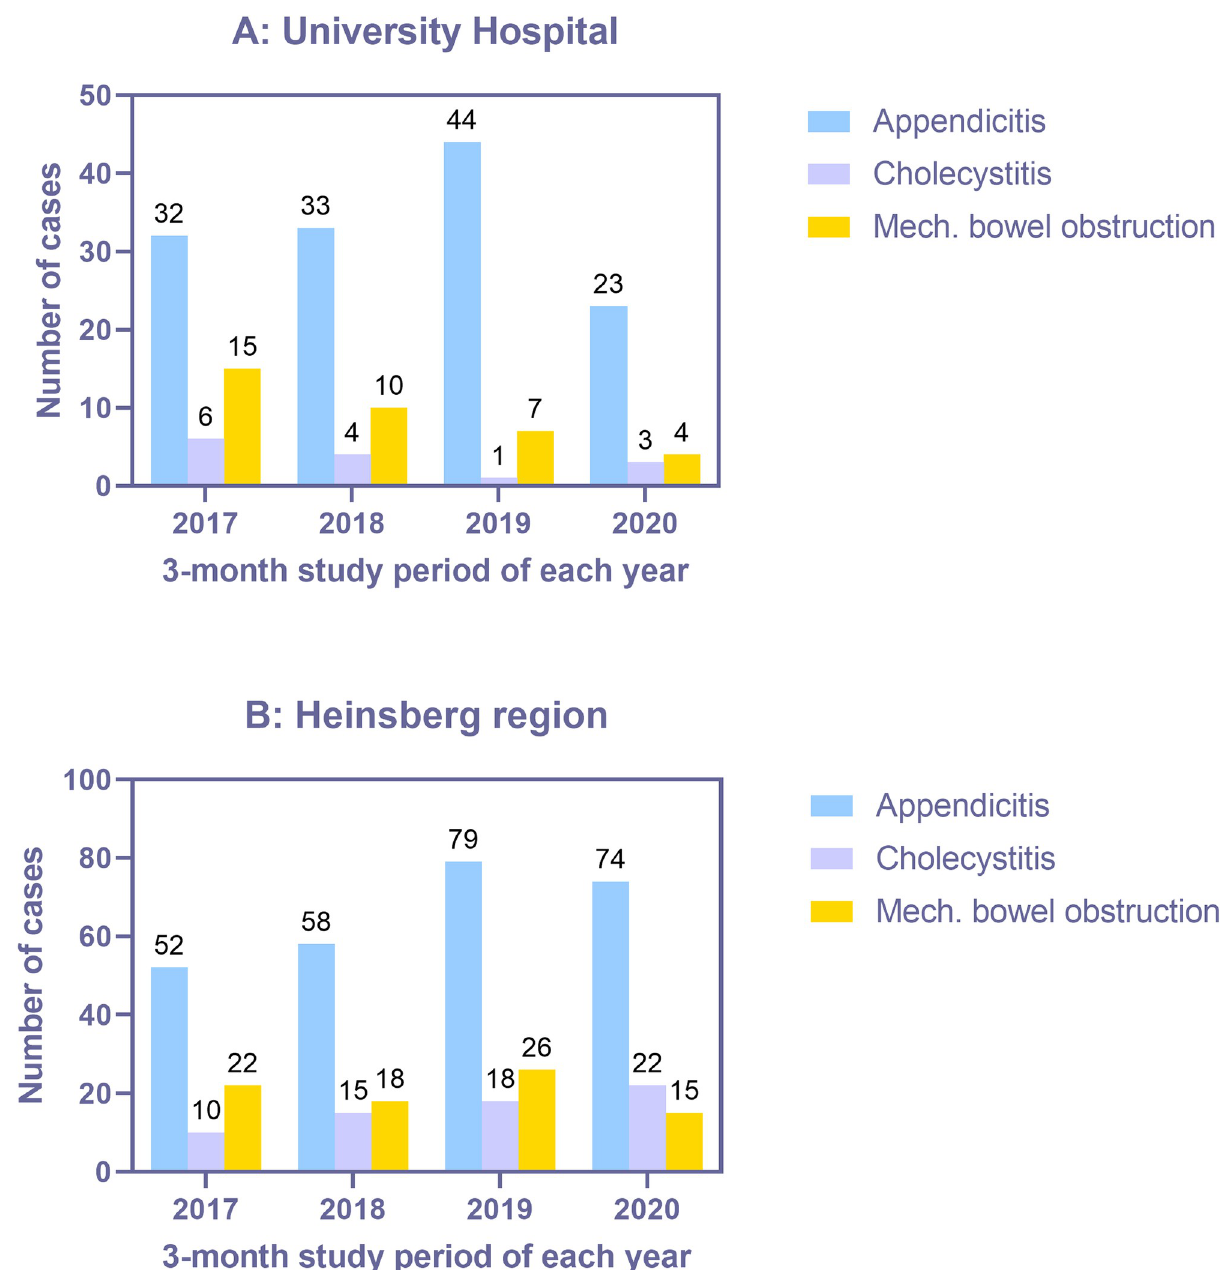
Fig 1. Incidence distribution over the years during the respective three month study intervals. A. University Hospital. B. Heinsberg